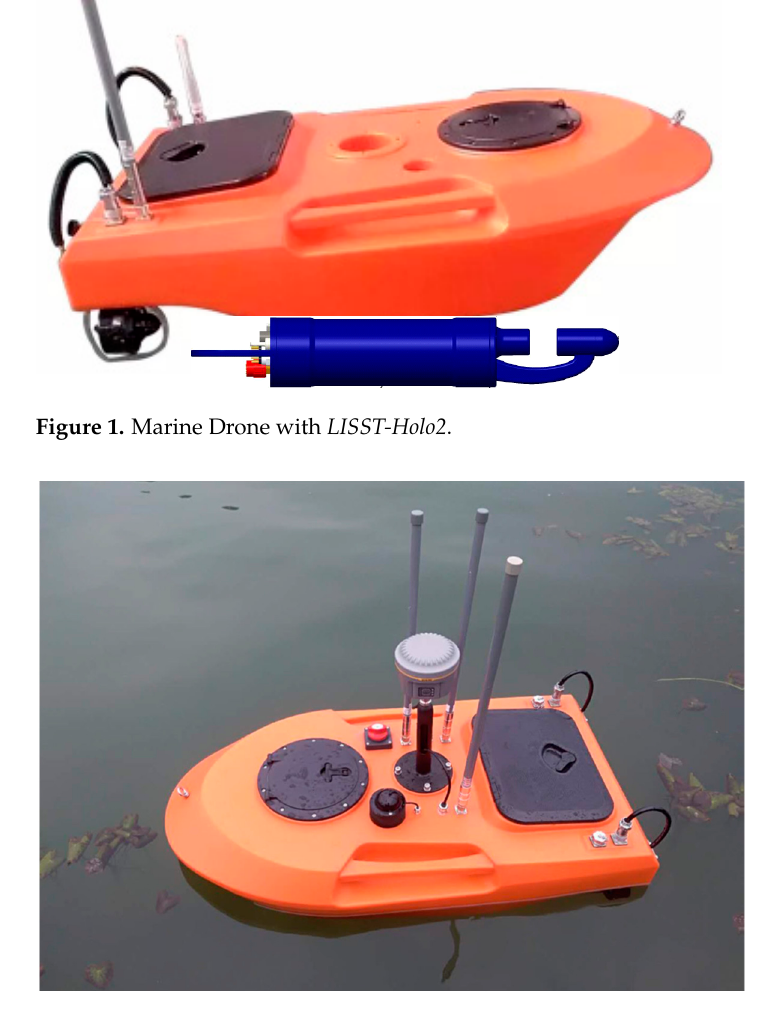
Figure 1. Marine Drone With LISST-Holo2.